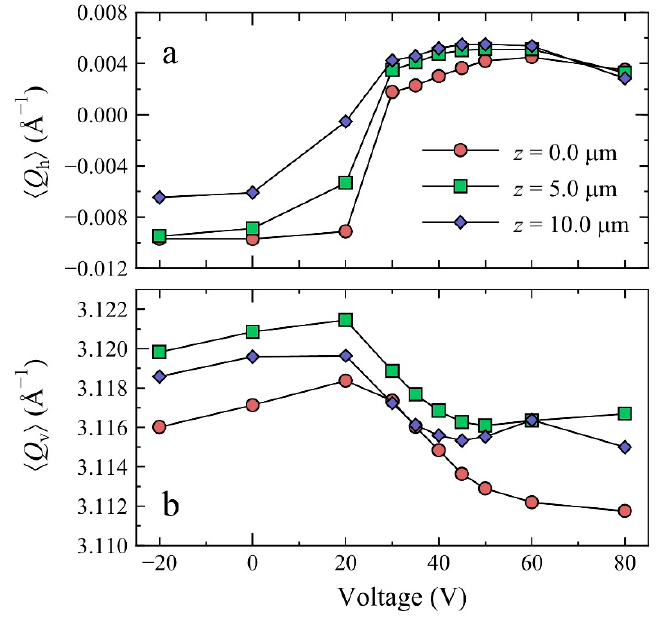
Figure 7. DC field (voltage) dependences of ( a ) (cid:104) Q h (cid:105) and ( b ) (cid:104) Q v (cid:105) at local locations of z = 0.0, 5.0, and 10.0 µ m in the nanobeam XRD for local structure under DC field.